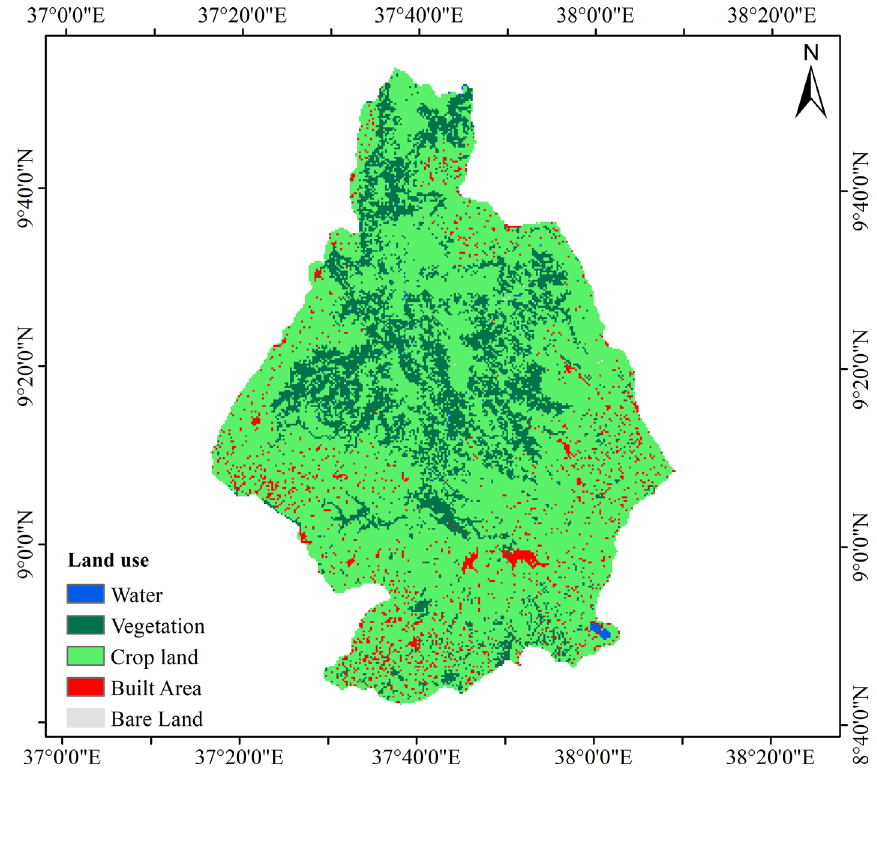
Fig. 4 Soil type of Guder